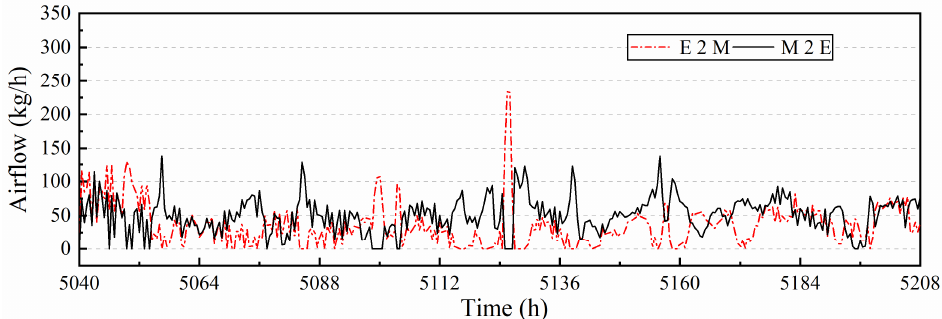
Figure 18. The airflow exchange calculated by CONTAM program between East and Middle.